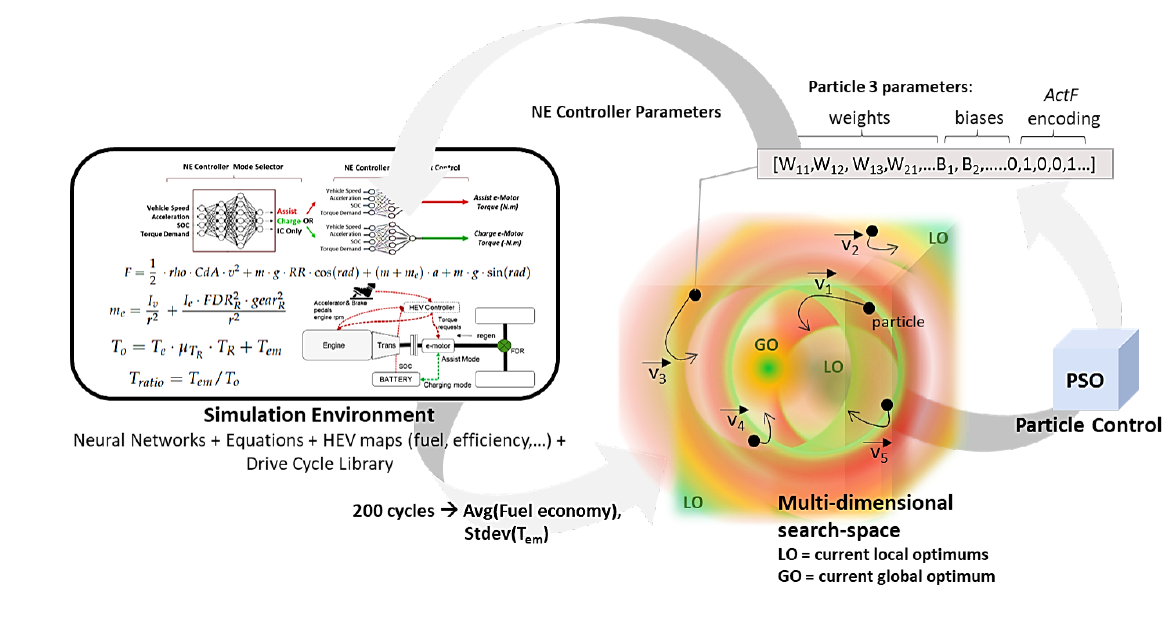
Figure 6. Simulation based offline learning process driven by the PSO algorithm.